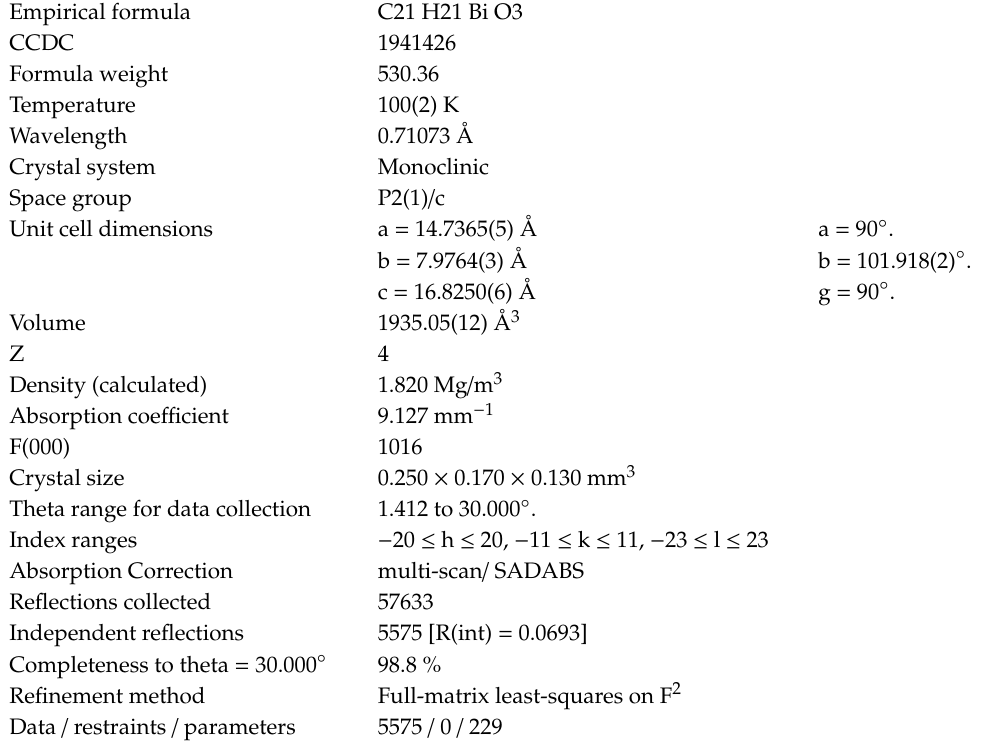
Figure S1: Overlay of obtained 1H-NMR spectra from various sources respectively: (a) CS (b) CS synthesized in the own lab for control and (c) RM-SF; Figure S2: Overlay of APT-NMR spectra from various sources respectively: (a) CS (b) CS synthesized in the own lab for control and (c)